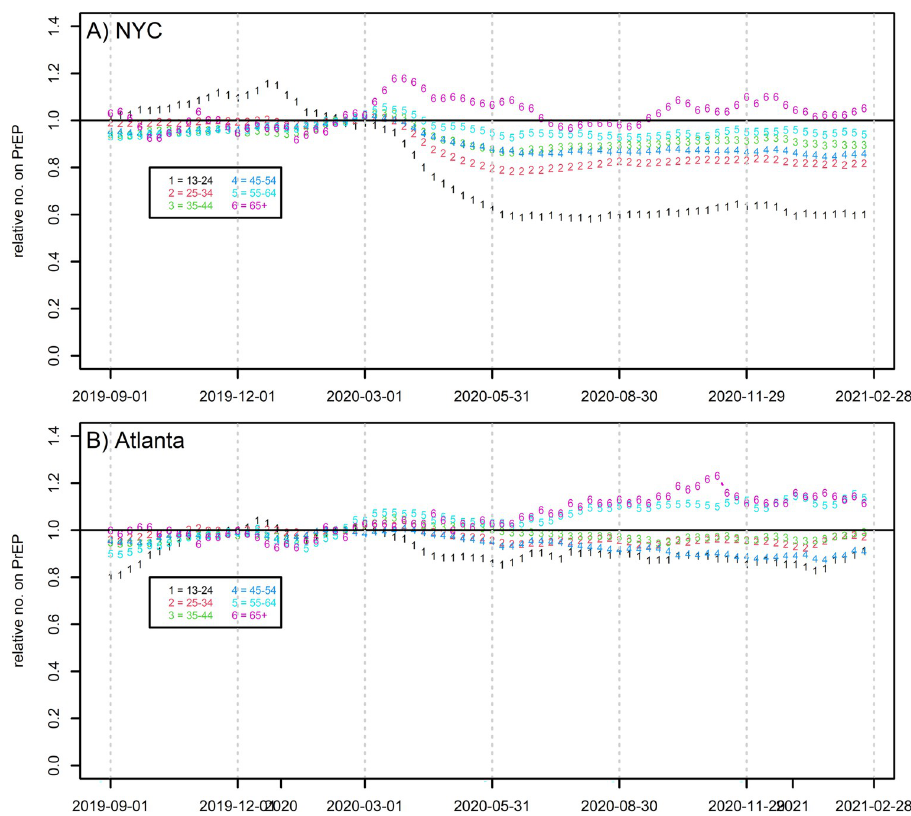
Fig 3. Prevalence of active PrEP prescriptions by age, relative to the weekly mean Feb. 2 –Feb. 29, 2020. A) New York City B) Metro Atlanta.